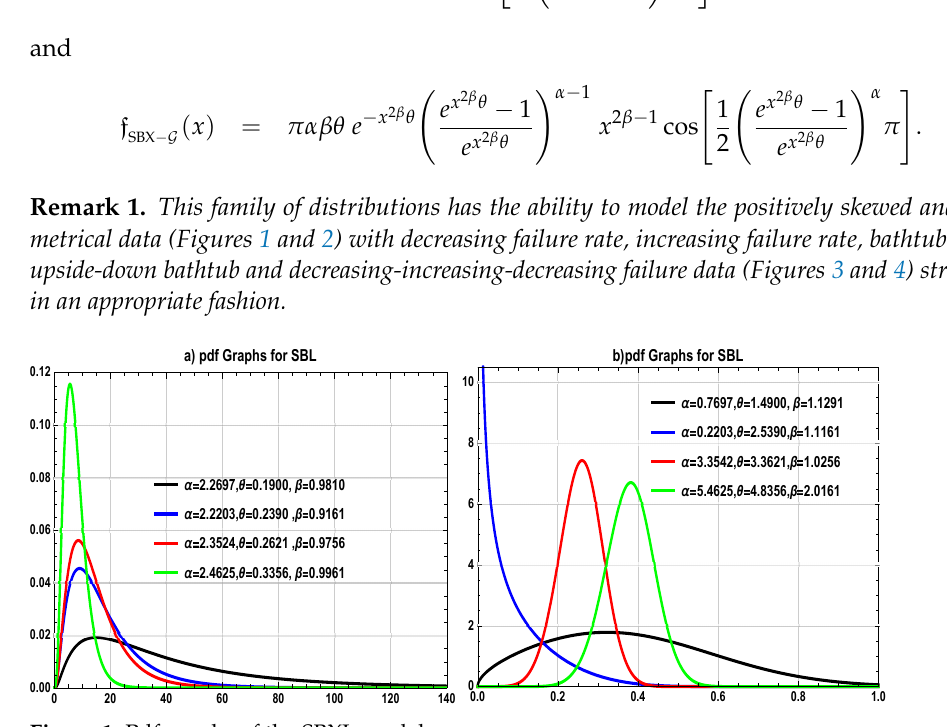
Figure 1. Pdf graphs of the SBXL